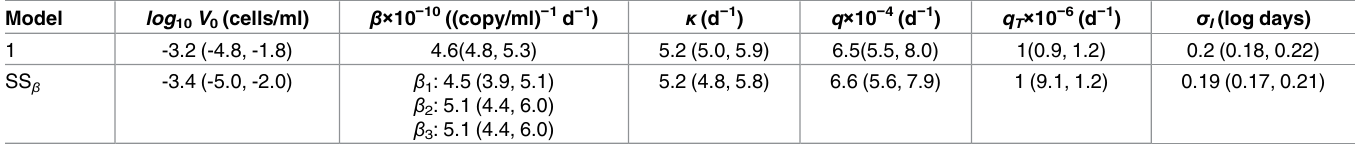
Table 3. Parameter estimates for model 1 and model SS β . Median marginal posterior parameter estimates are reported, with 95% posteriorcredible inter- vals for each parameter in parentheses. Model log 10 V 0